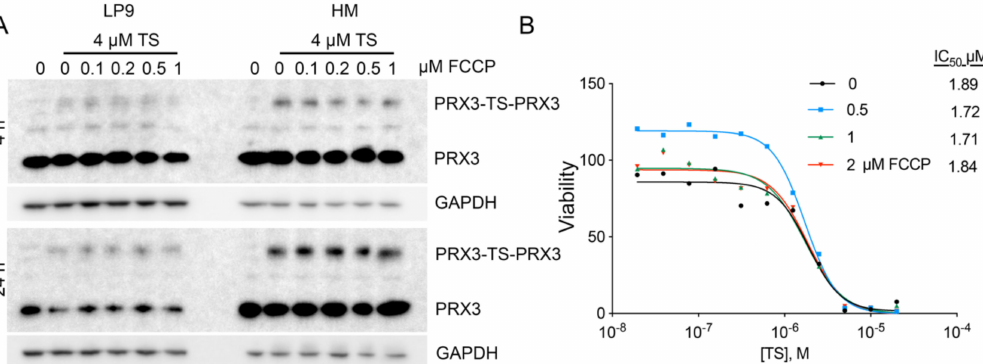
Figure 7. Intact mitochondrial membrane potential is not required for TS activity. ( A ) Western blots of normal LP9 and MM (HM cell line) cells incubated with 4 µ M TS alone or in combination with indicated concentrations of FCCP. Lysates were collected at 4- and 24-h post incubation and separated by reducing SDS-PAGE. ( B ) Dose response curves of HM cells incubated with TS alone or in combination with indicated concentrations of FCCP. IC 50 values ( µ M) are shown for indicated treatment